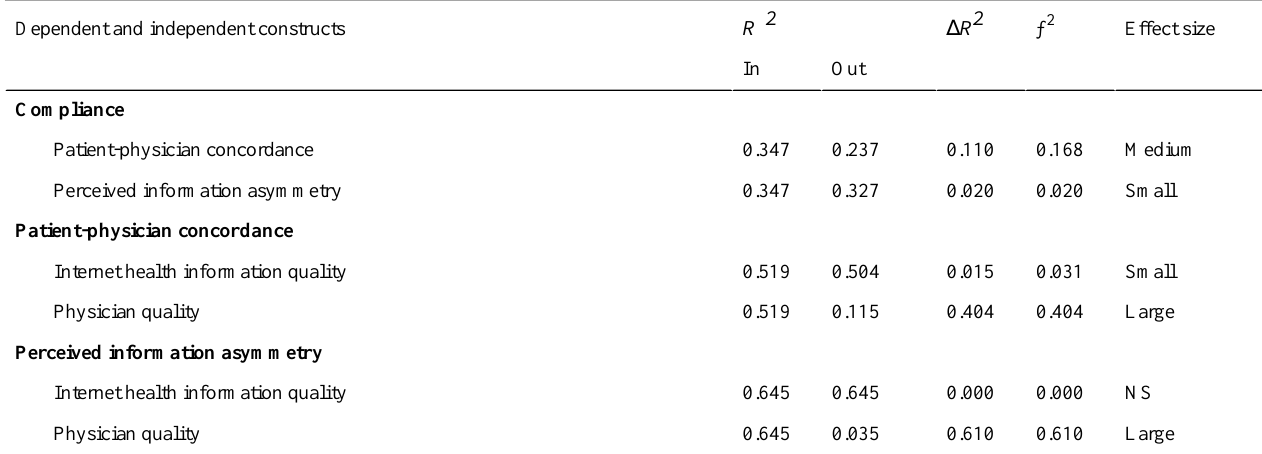
Table 4. Partial least squares effect size